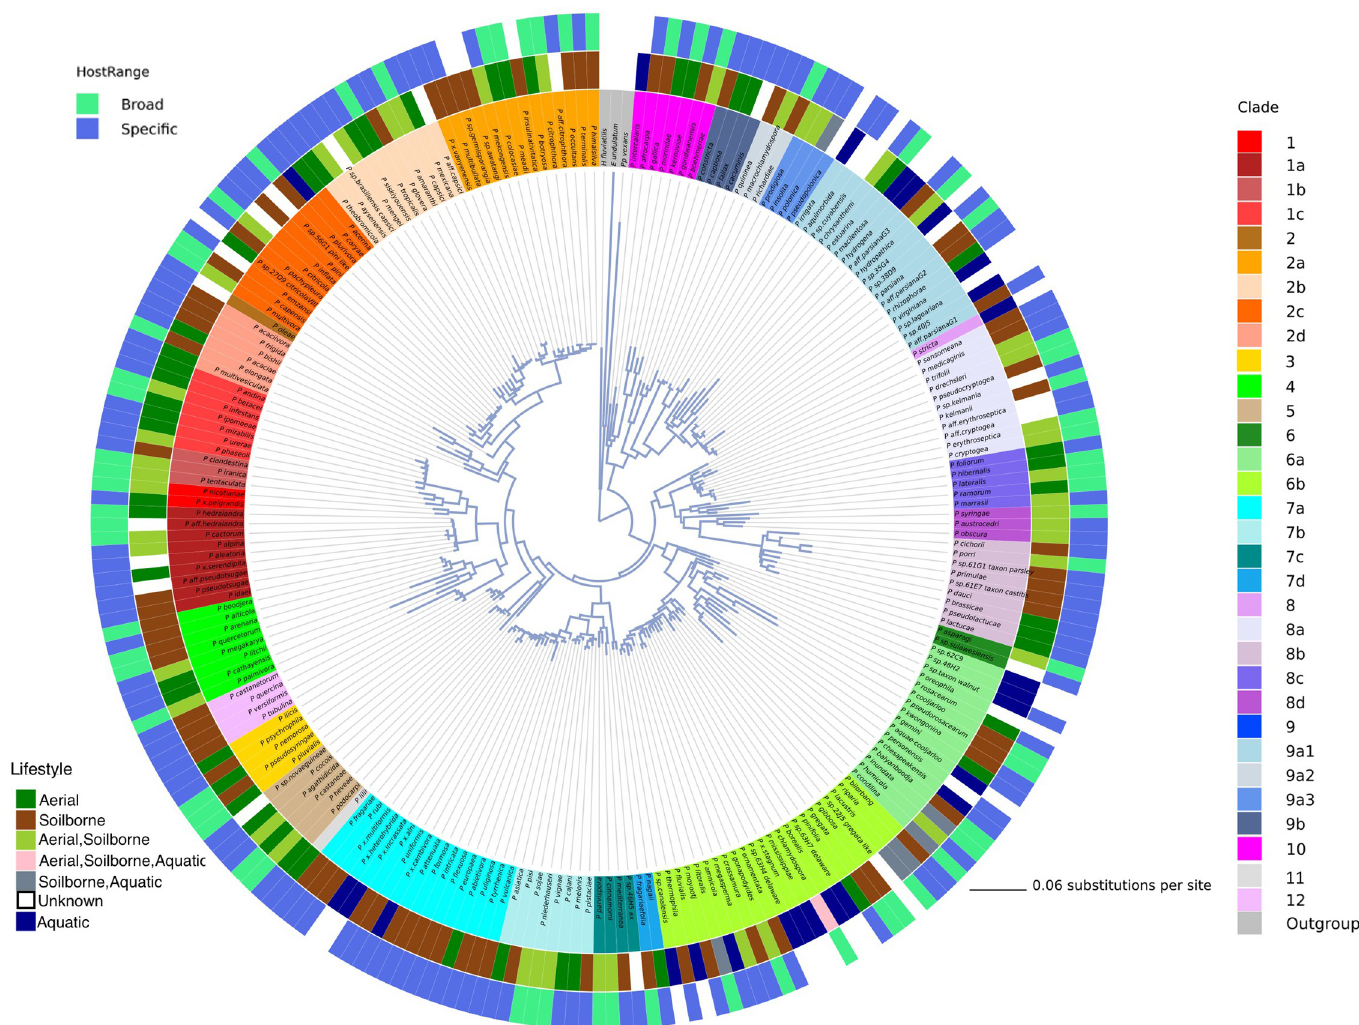
Fig 2. Phylogeny of the Phytophthora genus. Radial phylogeny of the genus Phytophthora inferred with maximum likelihood and 1,000 bootstrap replicates for an alignment of 8 concatenated nuclear genes. Coloring on the inner ring indicates clade. Colors on the middle ring indicate substrate. Colors on the outer ring indicate host range (broad, specific, or no host reported). The branches in the tree are drawn to scale and the scale bar represents 0.06 substitutions per site.